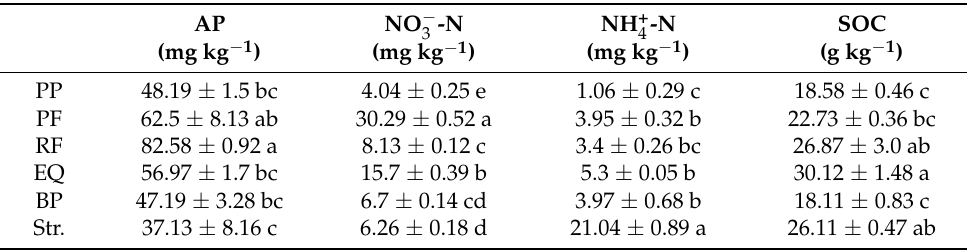
Table 1. Soil physiochemical properties (mean ± SE) and statistical results at the end of the condi- tioning phase and in the sterile soil.